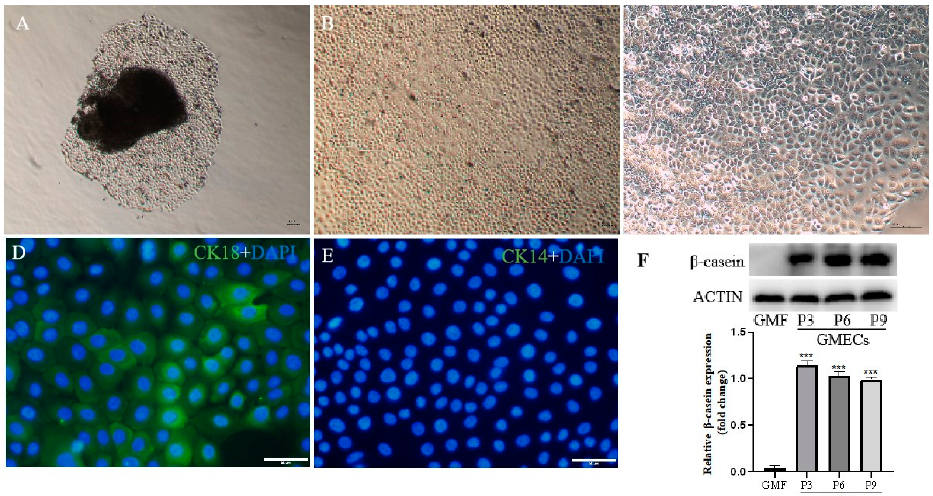
Figure 3. Characterization of gMECs. ( A ) Representative images of gMECs that migrated out of the mammary tissue after about 5 days’ culture; ( B ) representative images of gMECs spread across the bottom of the dish after another 5 days’ culture; ( C ) dome-like structures could be observed in cells cultured at a high density; ( D ) representative images of cytokeratin 18 (CK-18) detected using immunofluorescence; ( E ) representative images of cytokeratin 14 (CK-14) detected using immunofluorescence; ( F ) the β -casein of gMECs expressed in passages 3, 6 and 9 and was detected by western blot; GMF = goat mammary fibroblast; GMECs = goat mammary epithelial cells; ***: p < 0.001. Original western blot figures in Figure